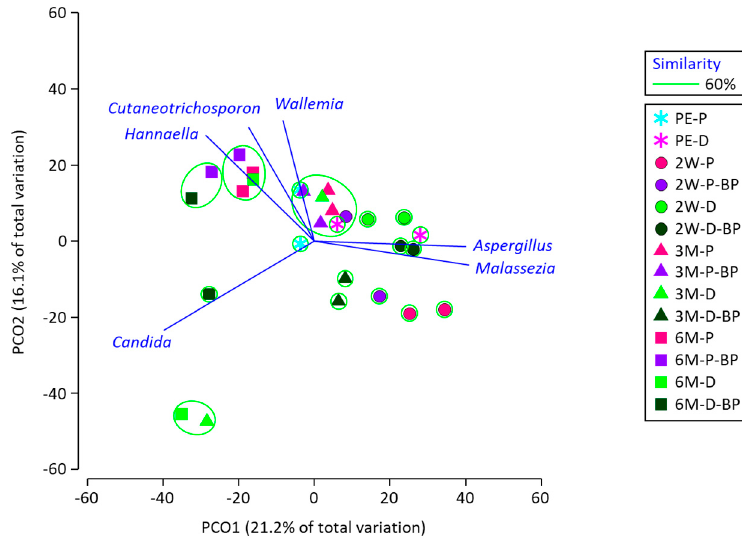
Figure 4. Principal coordinates plot characterizing fungal microbiota of soybean curd residue silage prepared with prompt and delayed sealing and with and without beet pulp addition. The operational taxonomy unit with a Pearson’s correlation of > 0.7 is overlaid on the plot as vectors. Samples enclosed in the same group at a 60% similarity level are denoted with green circles. PE, 2W, 3M, and 6M indicate pre-ensiled material and silage stored for 2 weeks, 3 months, and 6 months, respectively. P, D, and BP after the hyphenation denote prompt sealing, delayed sealing, and beet pulp addition, respectively.